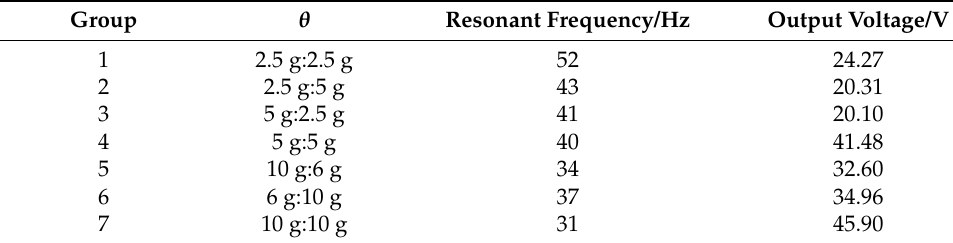
Table 2. Output voltages with different mass ratios.